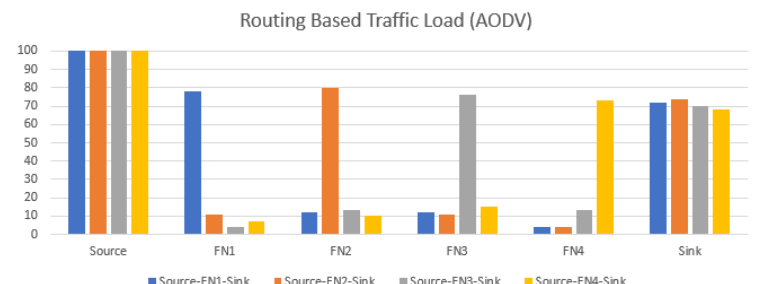
Figure 14. Traffic load: AODV.